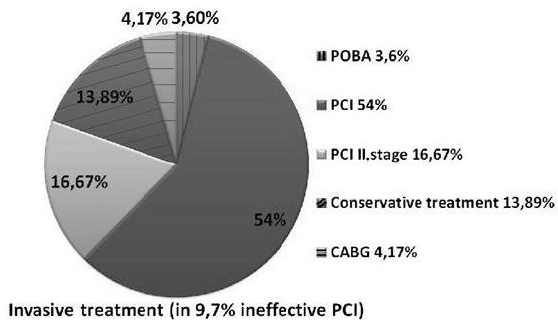
Figure 2. Form of therapeutic treatment. POBA - percutaneous bal- loon angioplasty, PCI - percutaneous coronary interven- tion, CABG - coronary artery bypass graft.